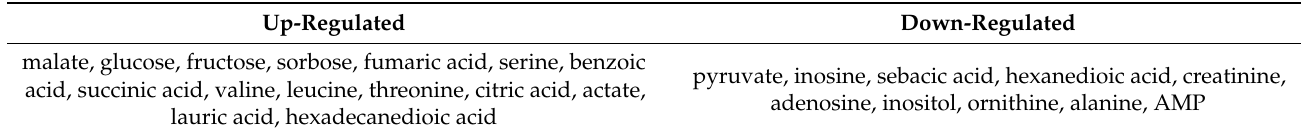
Figure 2. Differential metabolome of SCC-9 cells in response to cisplatin. Cluster analysis of the differential metabolites ( A ). The Z value distribution map of the differential metabolites, with untreated group as the control ( B ). SCC9_0, SCC9_1 and SCC9_2 represent the SCC-9 cells treated with cisplatin for 0 h, 24 h or 48 h. Table 1. The common differential metabolites in SCC-9 cells treated with cisplatin for 24 h or 48